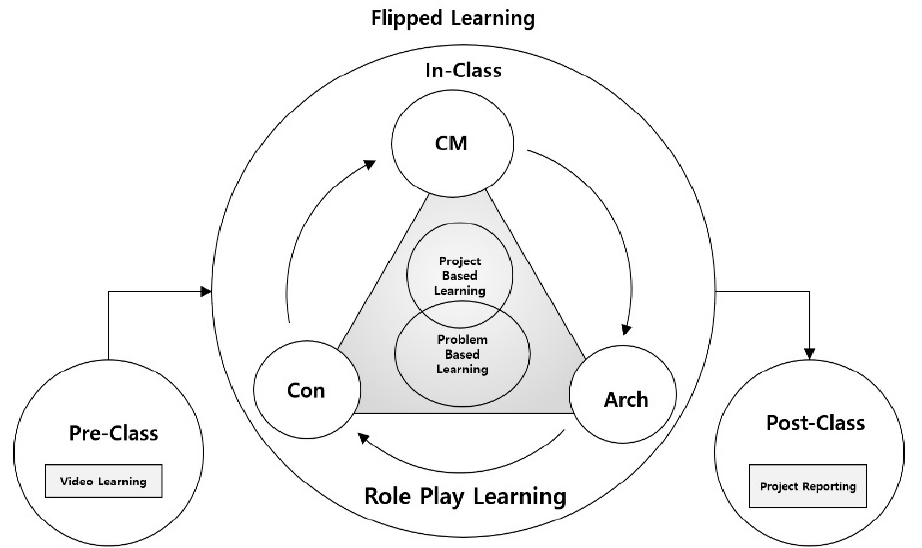
Figure 2. Hypothesis model of “Constructivism Education Theory (CCP)” for building information modeling (BIM) collaboration.